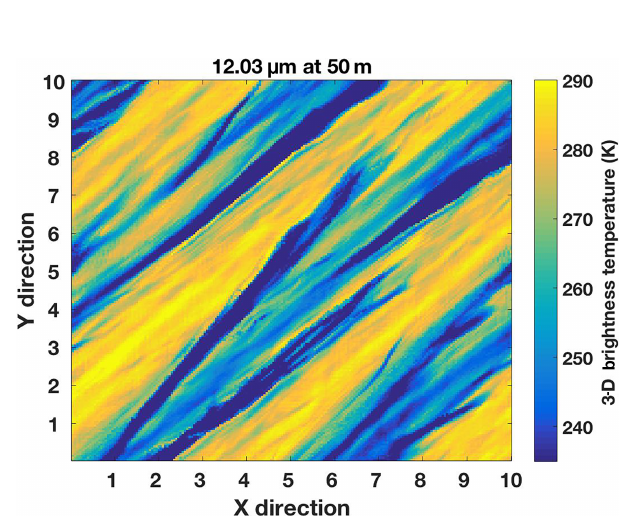
Figure 4. TOA brightness temperature field at